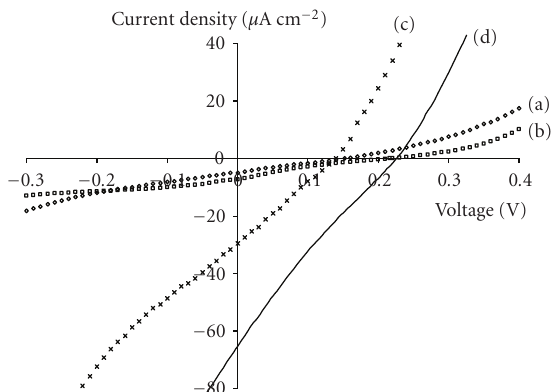
Figure 4: Current density versus voltage characteristics under illumination for (a) ITO / TiO 2 / 55wt.% chitosan+45 wt.% NH 4 I / ITO, (b) ITO / TiO 2 / 33wt.% chitosan+27 wt.% NH 4 I+40wt.% EC/ ITO, (c) ITO / TiO 2 / betalain dye (callus of Celosia plumosa )/ 27.5wt.% chitosan+22.5 wt.% NH 4 I+50 wt.% BMII/ITO, and (d) ITO / TiO 2 / anthocyanin dye (black rice) / 27 . 5wt.% chitosan+22.5 wt.% NH 4 I+50 wt.%